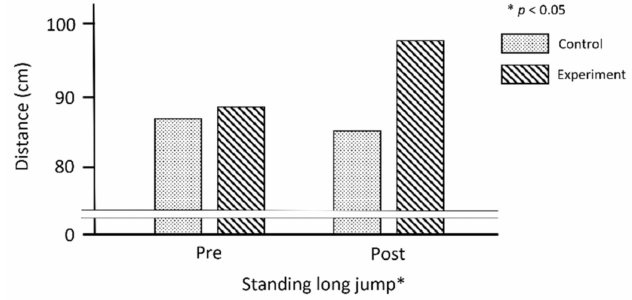
Figure 5. Muscle strength test results in physical fitness.